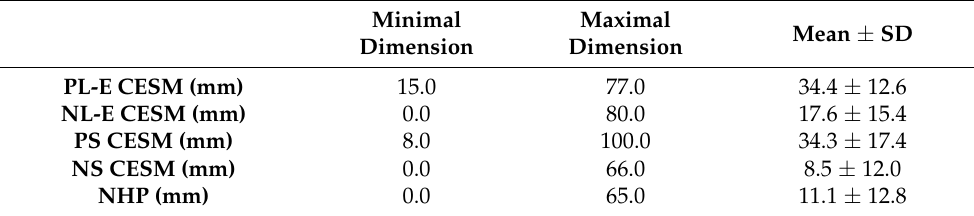
Table 2. Dimensions of the lesions before and after neoadjuvant chemotherapy for low-energy and subtraction CESM images and histopathological examination.